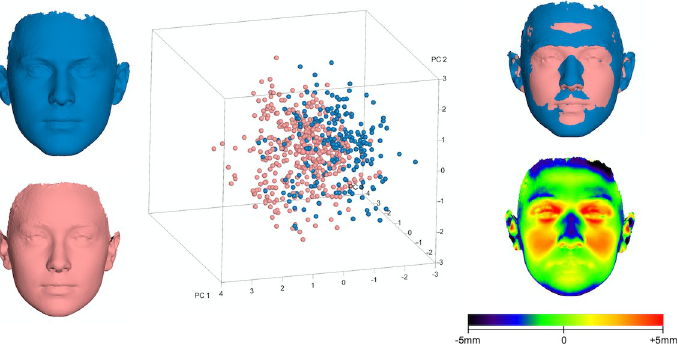
Fig 2. 3D PCA graph displaying facial variation according to sex (in SD units), in the entire sample, as explained by PC1 (20.9%), PC2 (15.1%) and PC3 (9%). The corresponding 3D facial morphings represent the average female (red) and male (blue) facial shapes. A best-fit superimposition (upper right) reveals the surface differences in facial shape between males and females and the color-map (lower right) displays the magnitude of those differences, as distance of the female from the male face (positive: forward).